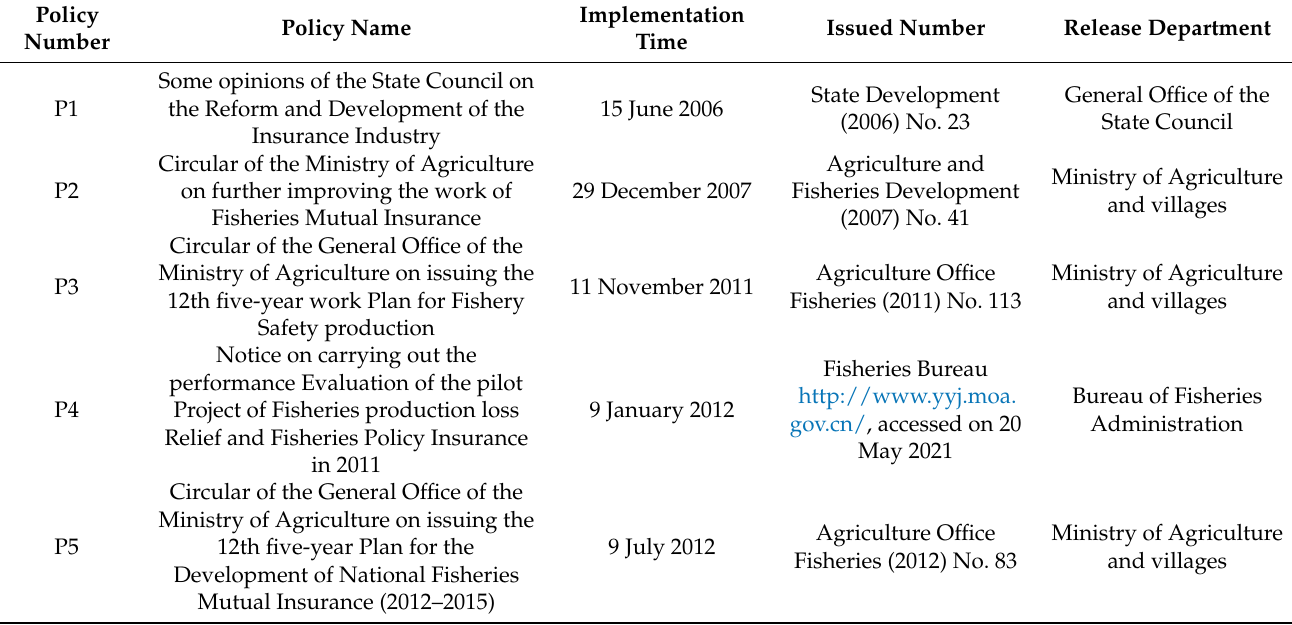
Table 3. List of 13 policies related to fishery